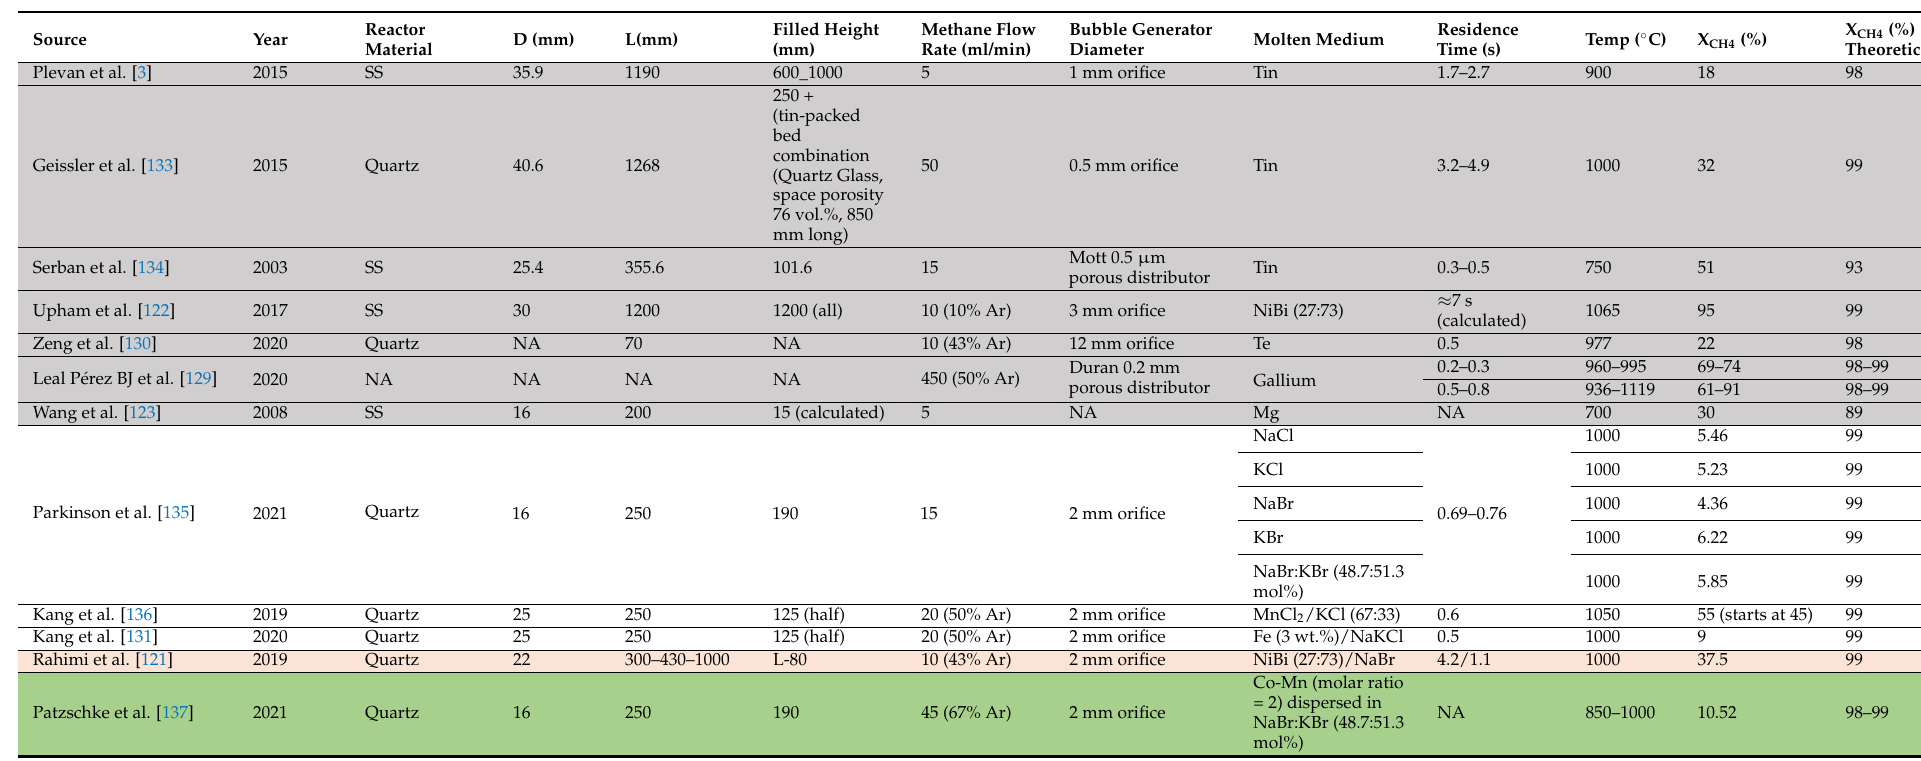
Table 2. Results of methane cracking main studies in molten media (gray: molten metals, white: molten salts, pink: two-phase molten media, green: metals suspended in molten salts).